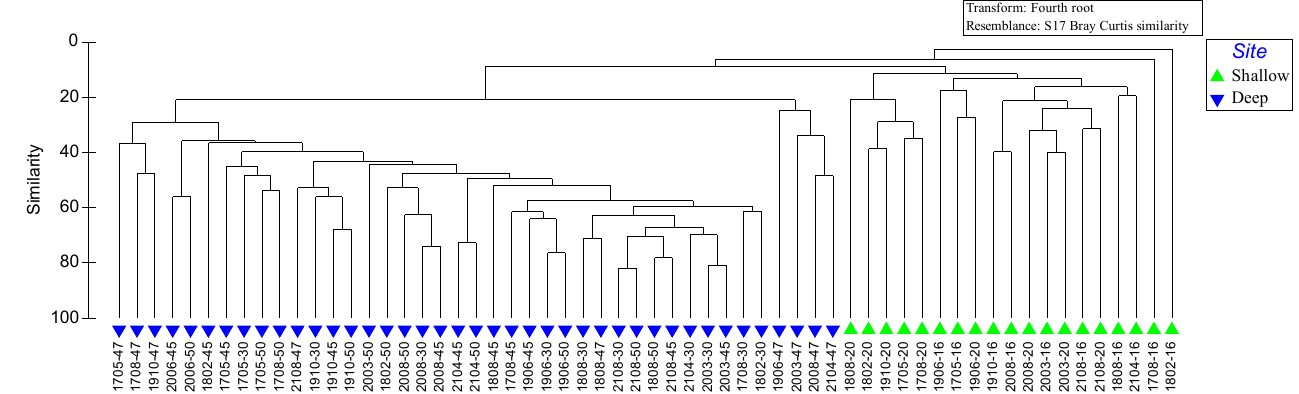
Figure 3. Cluster analysis of fourth-root-transformed macrobenthos density. Table 4. Similarity percentage (Simper) analysis of macrobenthos groups.